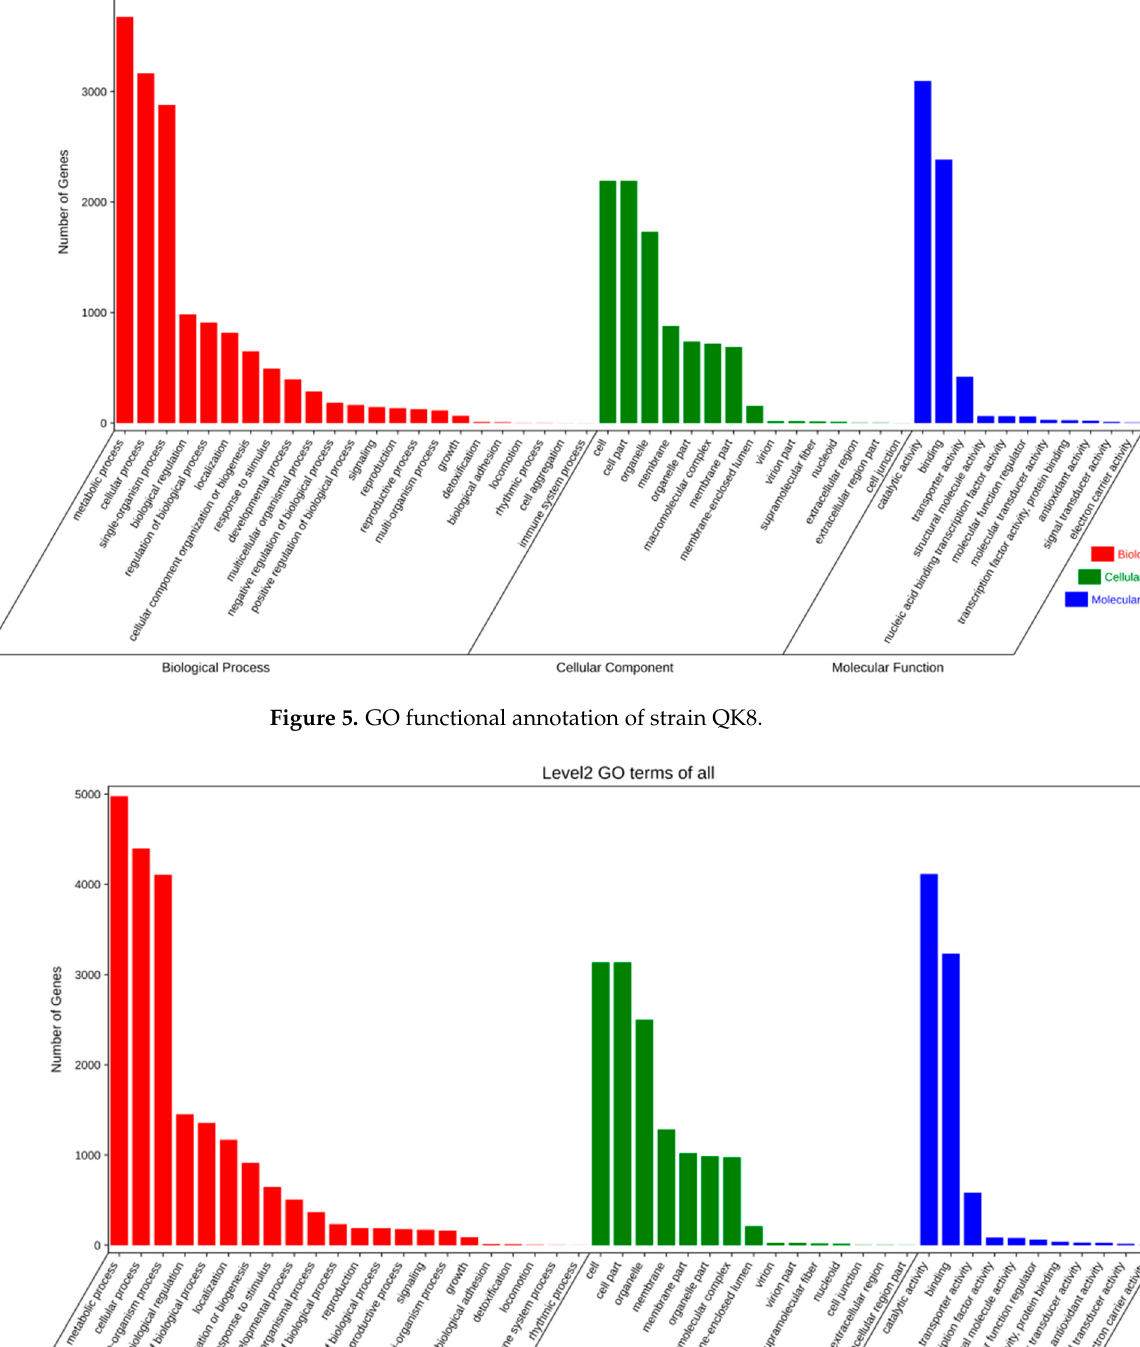
Figure 4. KEGG pathway annotation of strains QK8 ( A ) and SX13 ( B ).